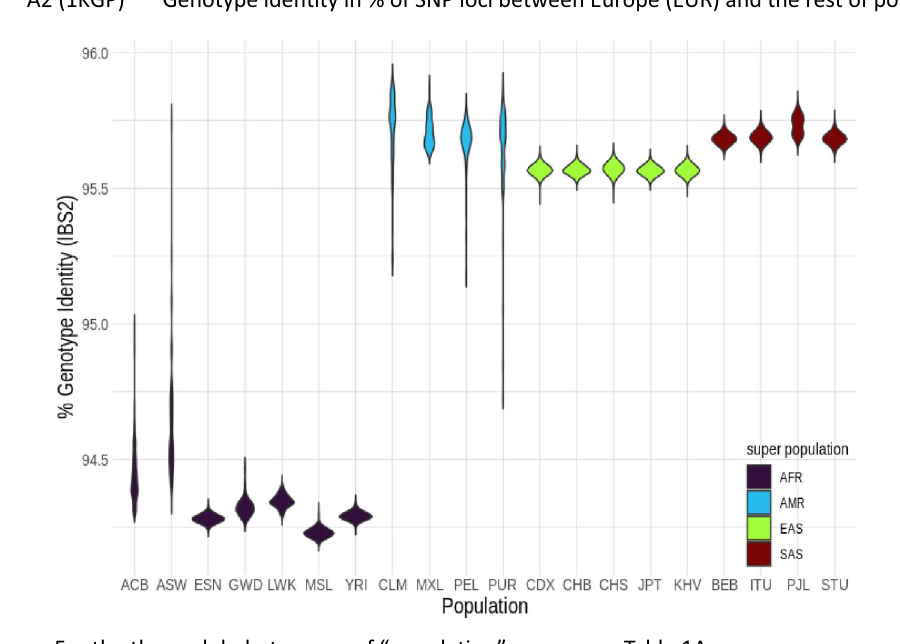
For the three-alphabet names of “popula(cid:7)on” groups see Table